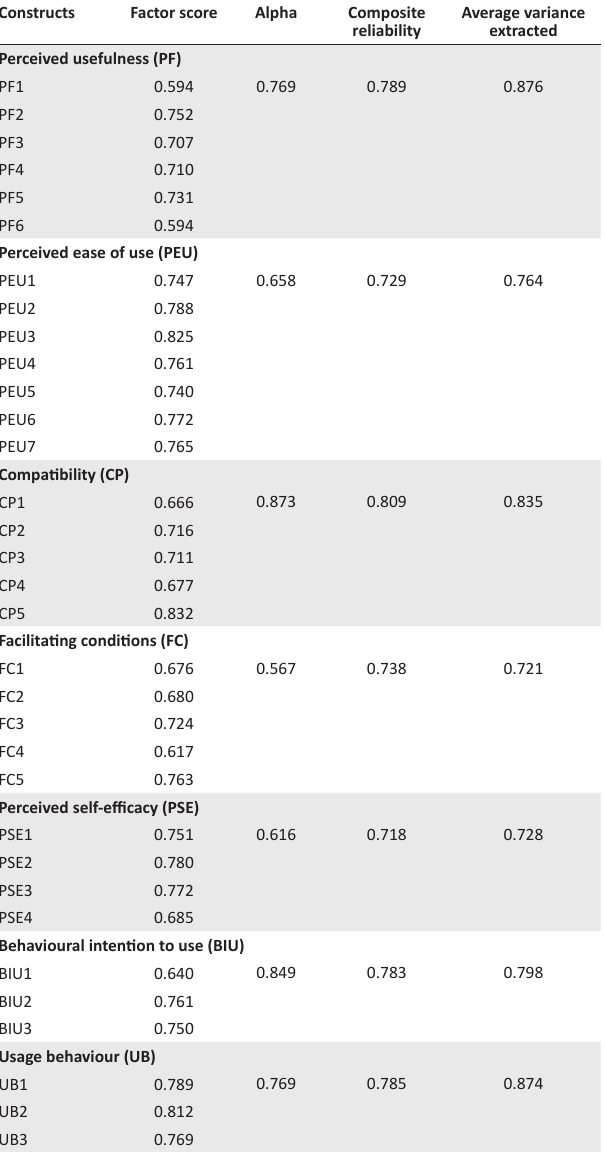
TABLE 3: Measurement model.